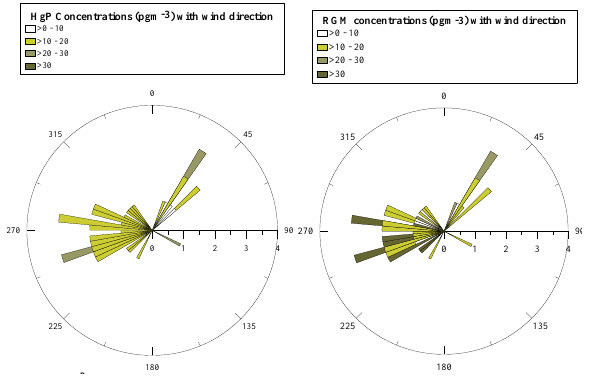
Figure 6: Hg P and RGM concentrations range with wind direction from 24 to 28 Jun 2007 during the study at Elora Research Station, ON showing the influence of wind direction on the Hg species concentration. Fig. 6. Hg P and RGM concentrations range with wind direction from 24 to 28 June 2007 during the study at Elora Research Sta- Fig. 7. Seasonal average day behaviour of GEM fluxes tion, ON showing the influence of wind direction on the Hg species (ngm − 2 hr − 1 ) measured at Elora Research Station, ON study site concentration. (1 November 2006 to 29 June